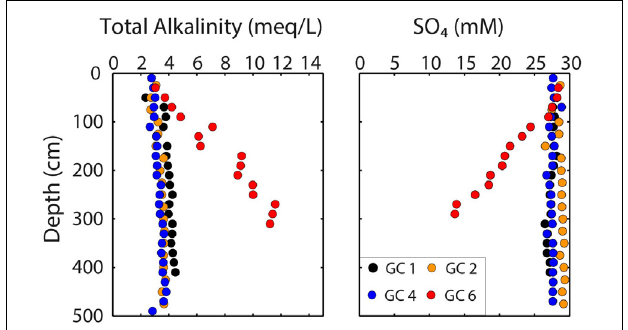
FIGURE 8 | Pore water profiles of total alkalinity [from Devey et al. (2018)] and SO 4 along an E-W transect on the Vema TFFZ (for locations see Figure 9